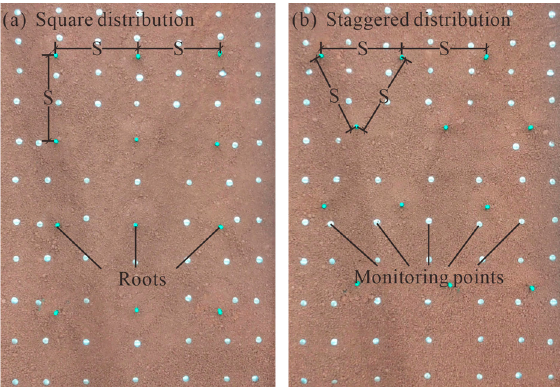
Figure 6. Planting pattern of root-soil composites and slope displacement tracking points. ( a ) Square distribution; ( b ) Staggered distribution.